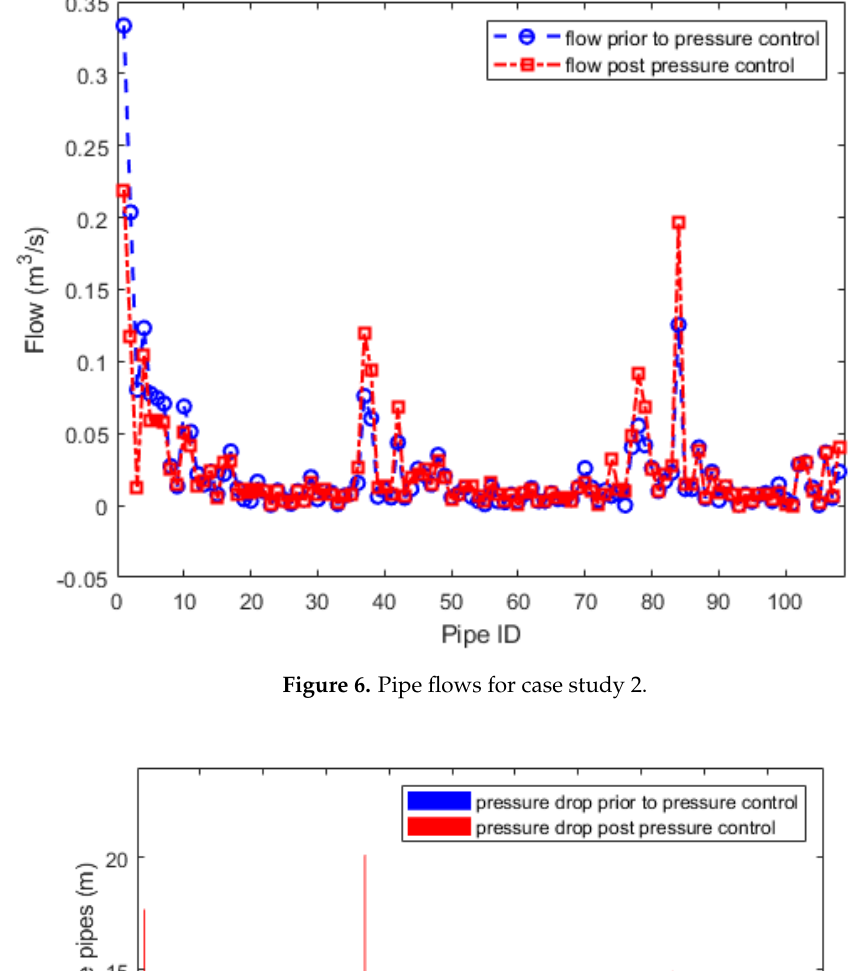
Figure 6. Pipe flows for case study 2.